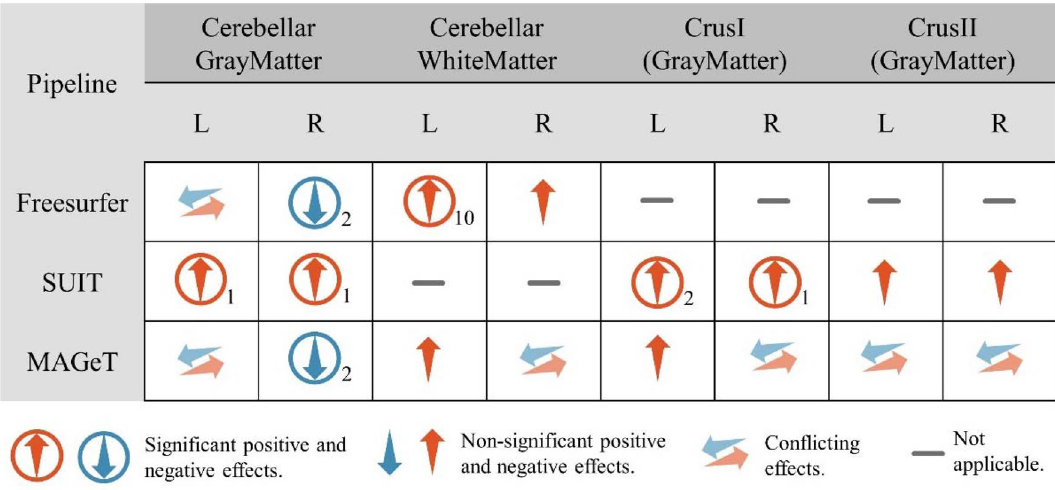
Figure 2. The overall hypothesis testing results across 10 statistical models and 3 pipelines. The columns are the cerebellar ROIs, the rows are different pipelines. Color and the arrow directions encode the sign of effect sizes, red up arrow denotes consistent increased ROI volume of ET group and blue down arrow indicates a reduction of ROI volume. Circles outside represent at least one significant result detected, the subscript on the bottom right corner of each glyph is the number of significant results across all the 10 statistical models (Table S2). Two horizontal arrows with lighter color represent conflicting results across the 10 different models. Gray short line indicates that no data available for the ROI from a specific